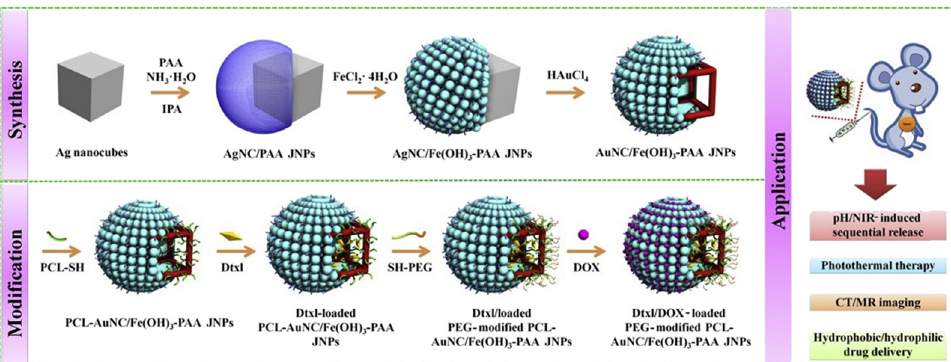
Figure 9. Schematic illustration of the fabrication, modification, and application of pH- and light- responsive AuNC/Fe(OH) 3 -PAA Janus nanoparticles. Reprinted/adapted with permission from Ref. [82]. Copyright 2018, Elsevier Ltd.